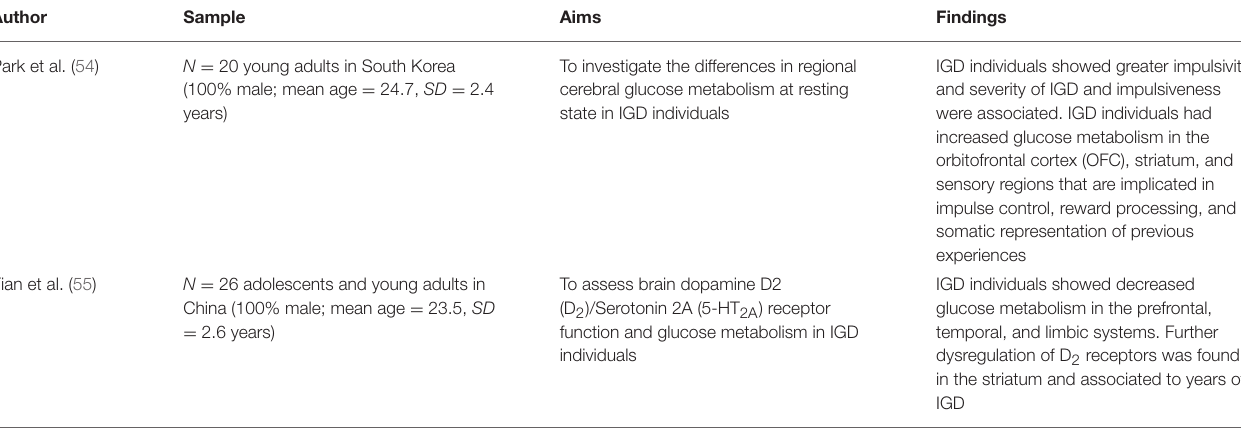
TABLE 4 | Positron emission tomography (PET) studies of Internet Gaming Disorder